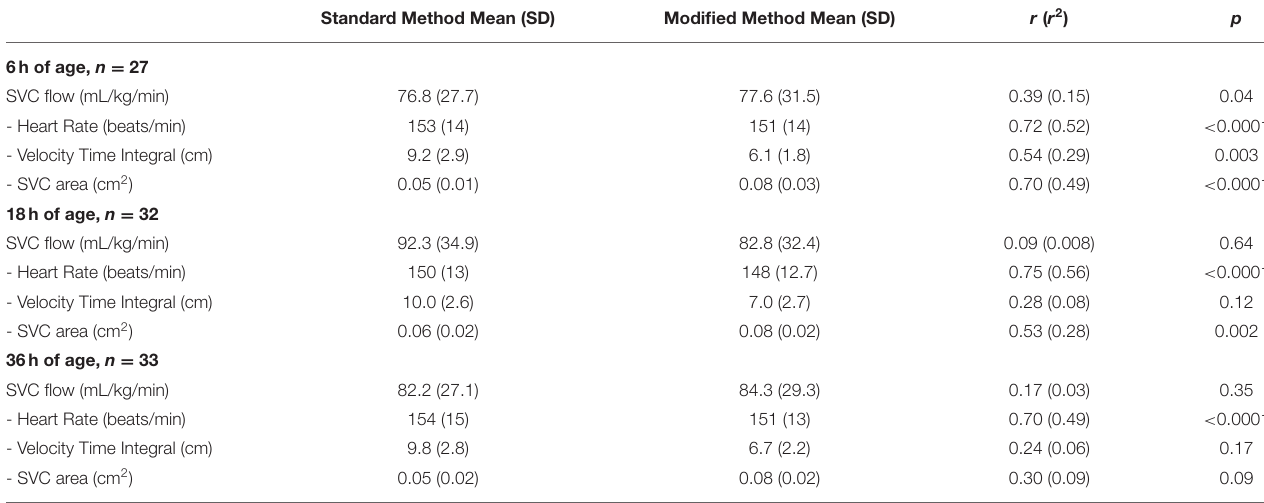
TABLE 3 | Correlation coefficients for standard Superior Vena Cava (SVC) flow measurement method and modified method, including all measurements used for the calculation of SVC flow for three time points.